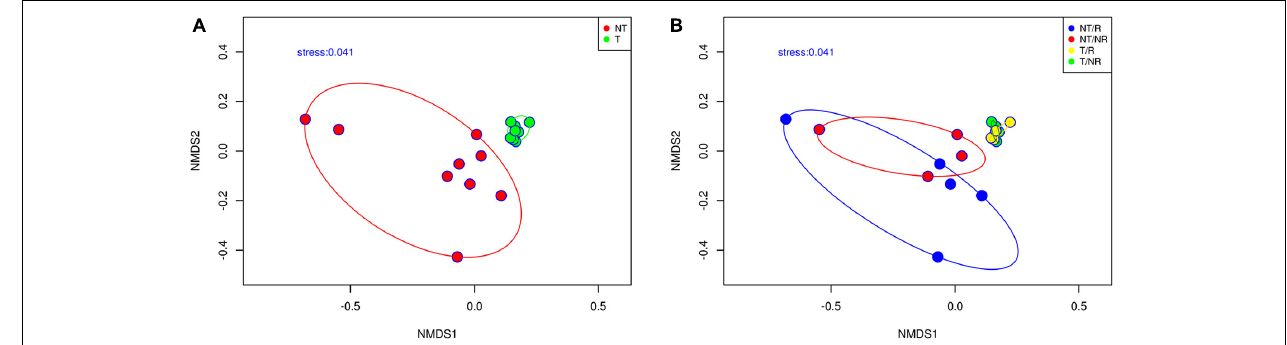
FIGURE 3 | Non-metric multidimensional scaling based on Bray Curtis dissimilarities showing (A) the effect of tilling and (B) the effect of rotation on the fungal community composition.